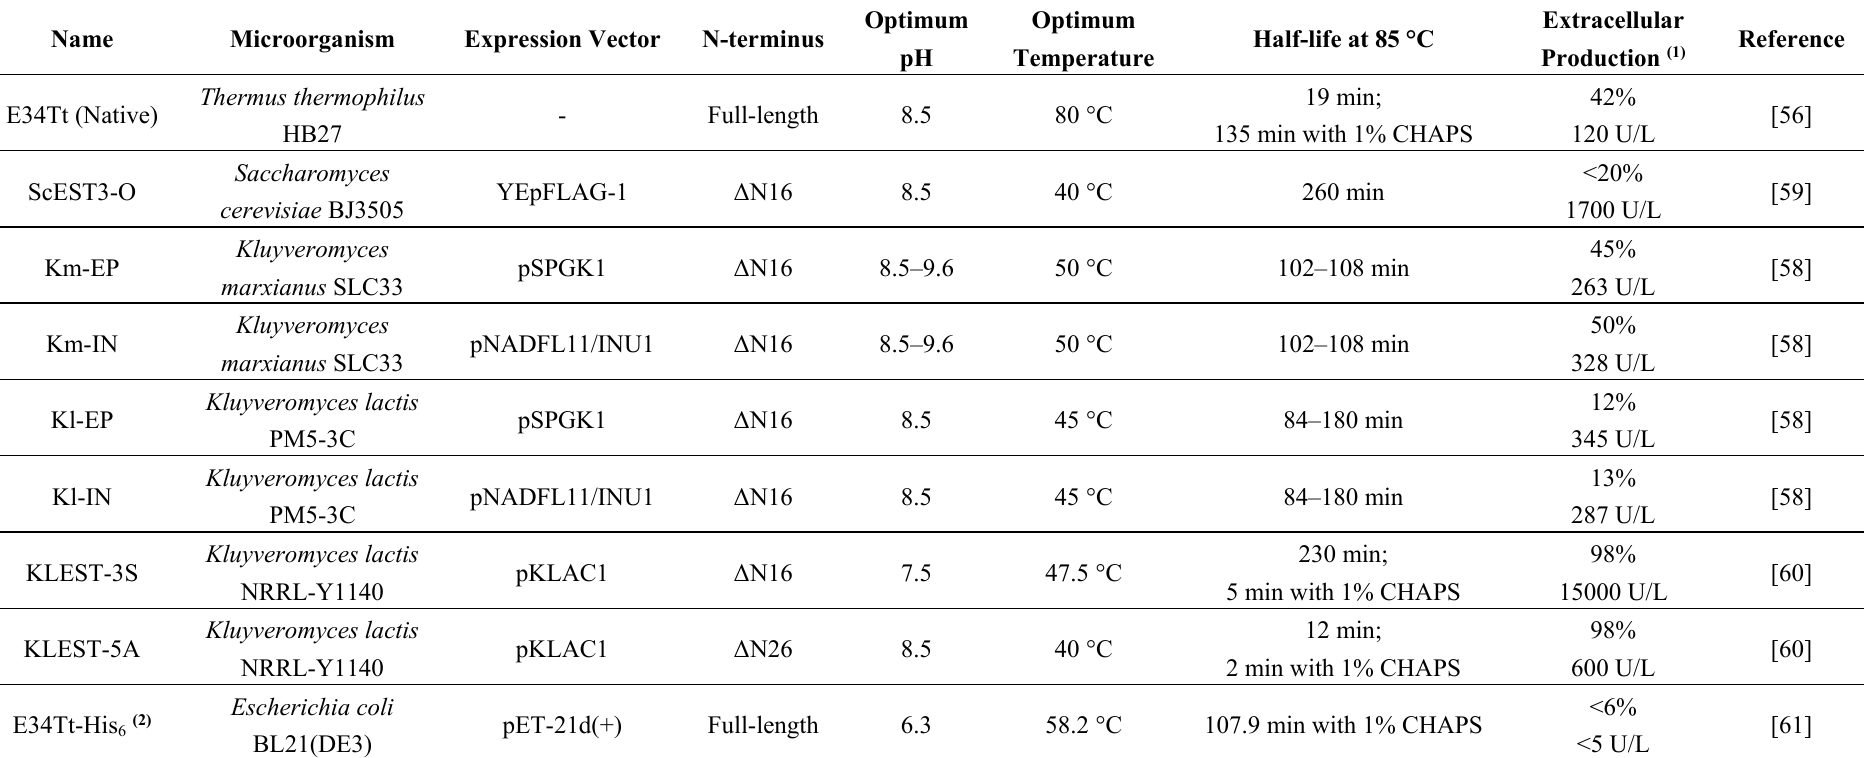
Table 1. Heterologous expression systems of the 34 kDa Thermus Thermophilus ( T. thermophilus ) esterase and characteristics of the recombinant proteins in comparison with the native